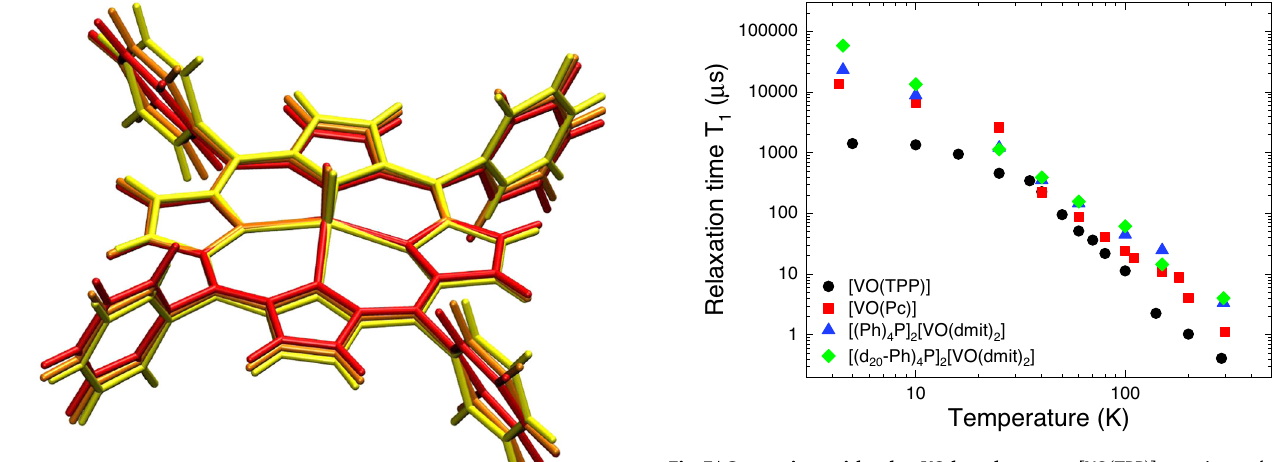
Fig. 7 | Comparison with other VO-based systems. [VO(TPP)] experimental spin- phononrelaxationtime T 1 (blackcircles) 27 comparedwithotherVO-basedsystems: VOPc(Pc=phthalocyanine,redsquares) 53 ,[(Ph) 4 P] 2 [VO(dmit) 2 ](dmit=1,3-dithiole- 2-thione-4,5-dithiolate, blue triangles) 54 and its analogue compound with a deut- erated cation, [(d 20 -Ph) 4 P] 2 [VO(dmit) 2 ] (green diamonds) 54 . All the samples were crystalline dispersions in their isostructural diamagnetic host: [TiO(TPP)] (2% dilution), TiOPc (0.1% dilution), [(Ph) 4 P] 2 [MoO(dmit) 2 ] (5% dilution) and [(d 20 - Ph) 4 P] 2 [MoO(dmit) 2 ] (5% dilution) (error bars are within the size of the